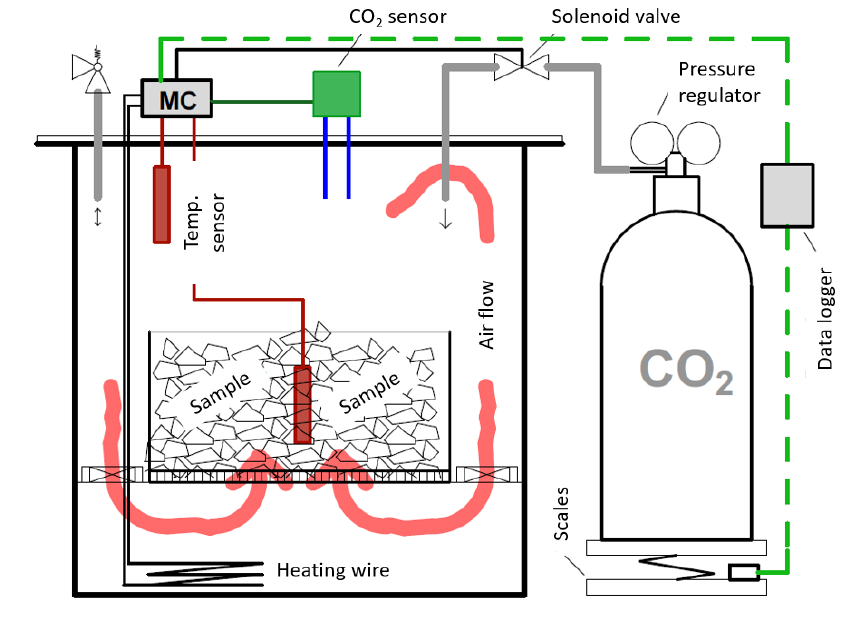
Figure 2. Simplified scheme of the test